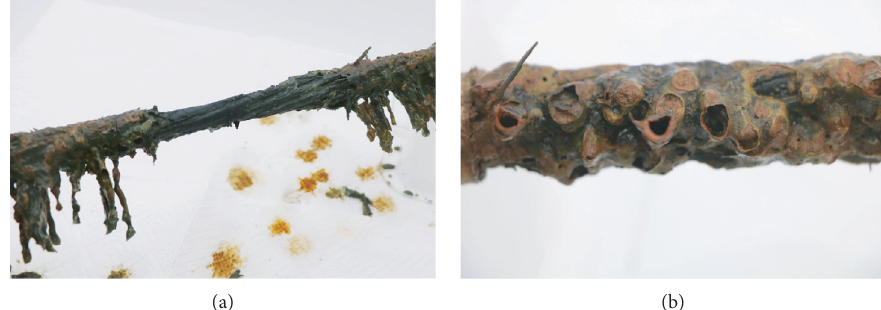
Figure 3: Morphology of corroded anchor sample. (a) Loose and flaky corrosion product; (b) distributed